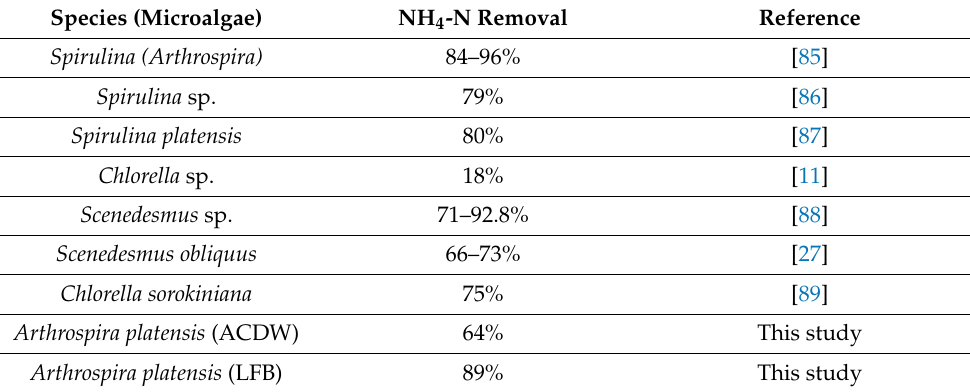
Table 5. Comparison of NH 4 -N removal by different species of